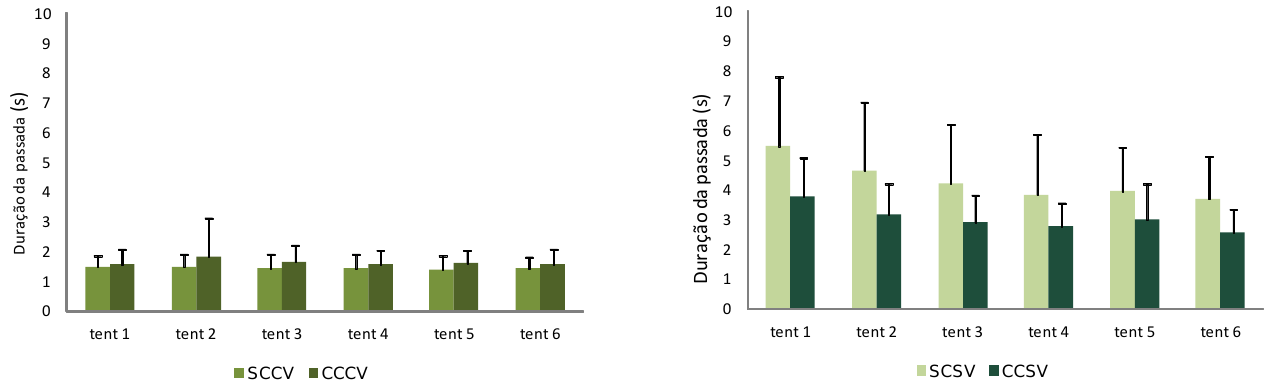
Figura 4. Média e desvio-padrão da duração das passadas nas condições experimentais com e sem o cão, mas com uso da visão (lado esquerdo) e com e sem o cão, mas sem o uso da visão (lado